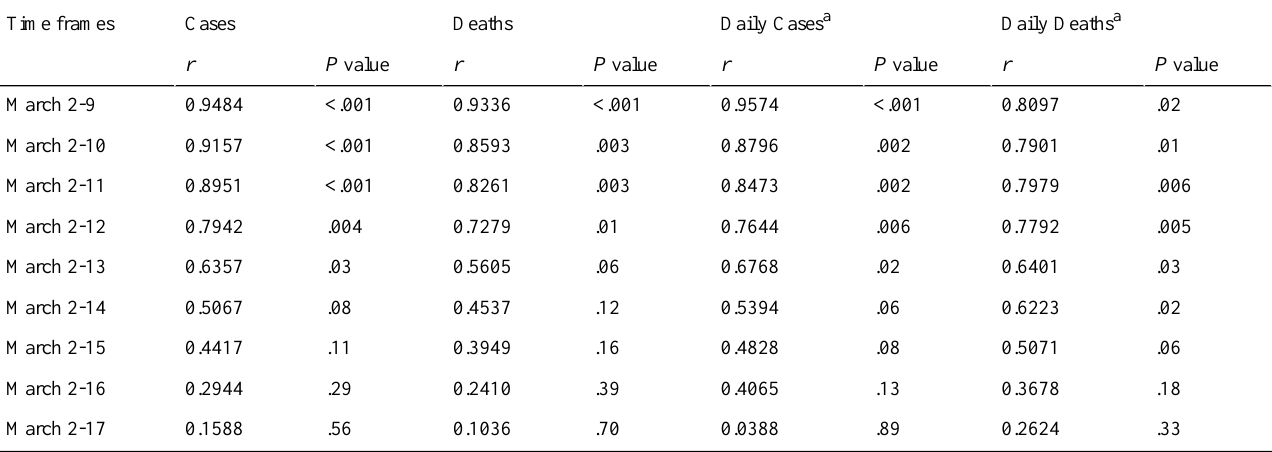
Table 2. Pearson correlation coefficients ( r ) between COVID-19 cases and deaths and Google Trends data in Italy.